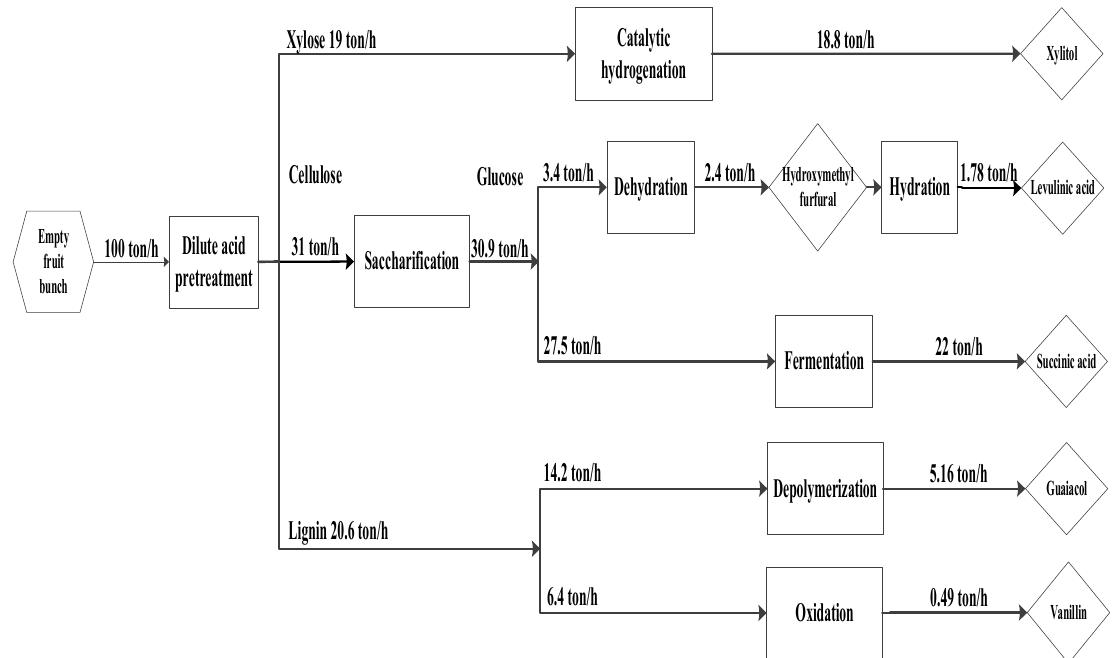
Figure 11. The optimal biorefinery configuration of the optimal point S1 for profit and toxicity damage index in Figure